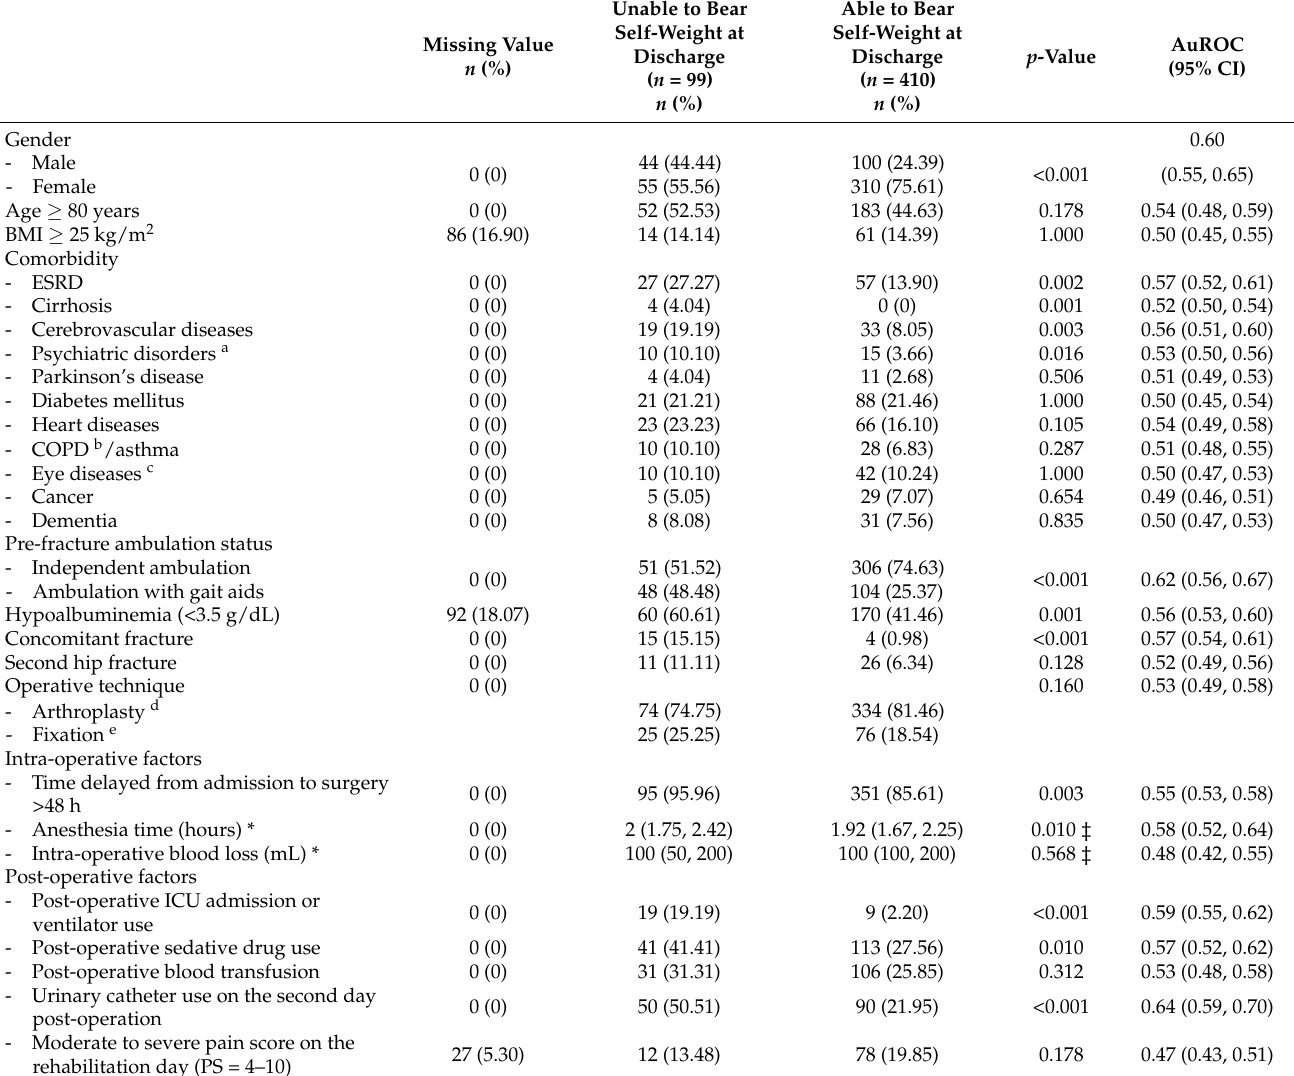
Table 1. Baseline characteristics and pre-, intra-, and post-operative factors of patients with fragility femoral neck fractures included in this cohort by their ability to bear self-weight at